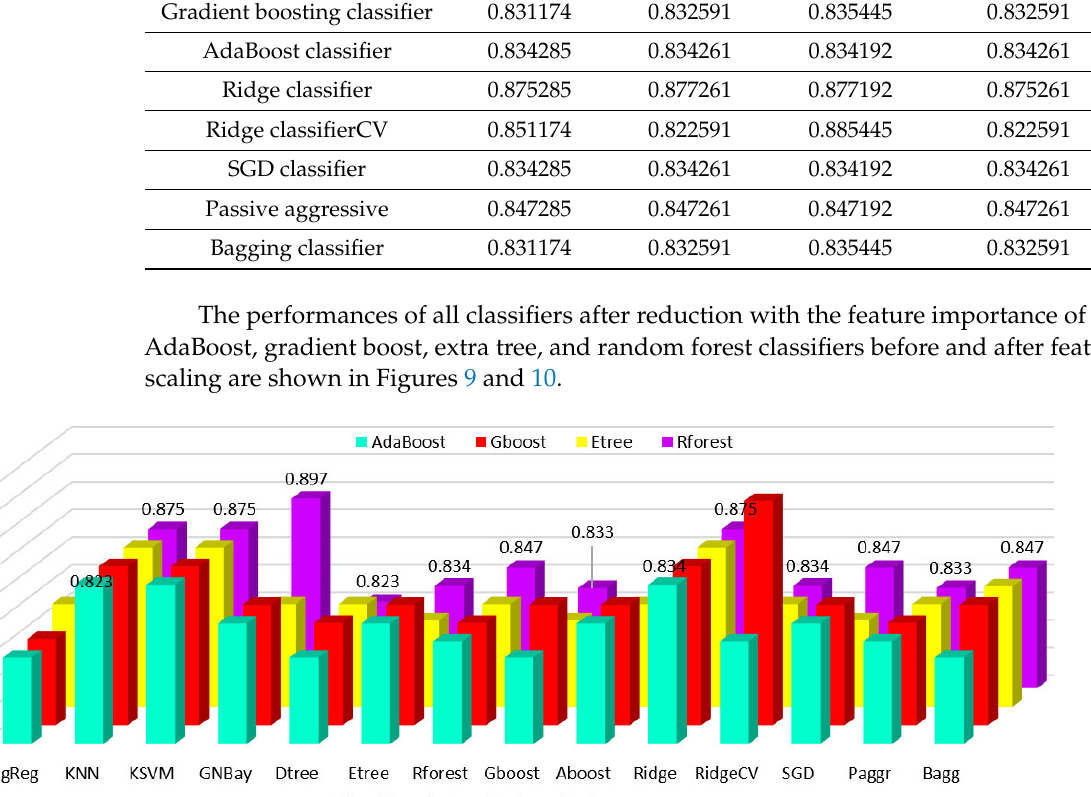
Figure 10. Classifier feature importance performance of all classifiers after scaling. The overall dataset was analyzed with the OLS features, such as p value, R squared, adjusted R squared, parameter coefficient, significance, AIC, BIC, standard error, F ‐ statis ‐ tic, log ‐ likelihood, residual MSE, model MSE, omnibus probability, and JarqueBera prob ‐ ability for all 255 subset combinations of the features. The following subset includes highly significant features based on the p values, and the parameters are listed in Tables 25–28 . Table 25. OLS features of the significant subset attributes of the hypothyroidism dataset. S.No